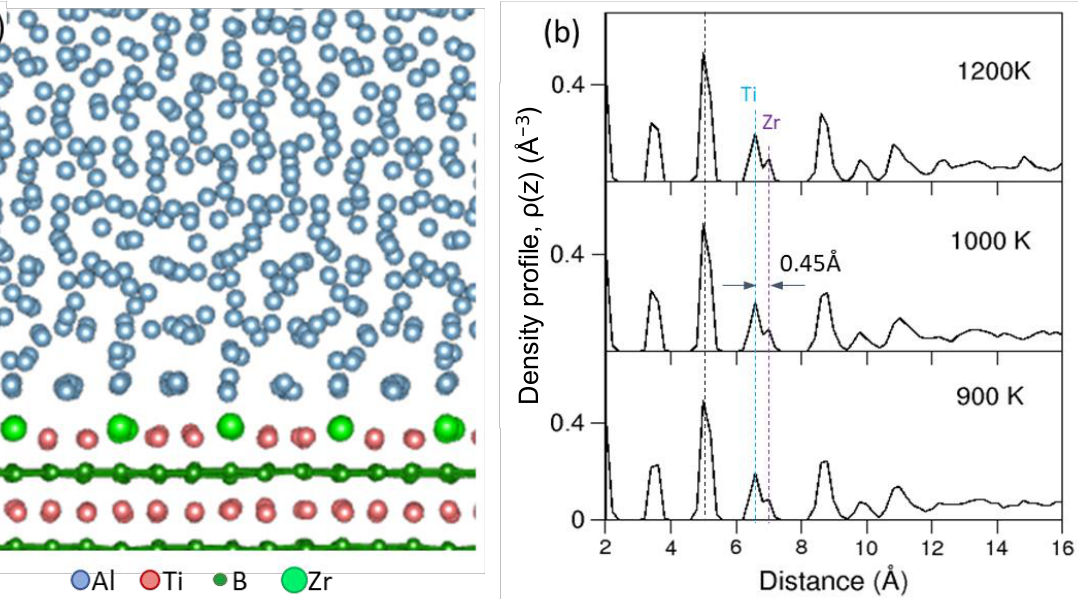
Figure 13. Ab initio MD simulation of Zr segregation at Al/TiB 2 interface [26]. ( a ) Snapshot of Al(liquid)/TiB 2 (Ti 2 Zr 2DC) interface along [1 0 1̅ 0] TiB 2 (Ti 2 Zr 2DC) direction simulated at 1000 K and ( b ) atomic density profiles ρ(z) across the Al(liquid)/TiB 2 (Ti 2 Zr 2DC) interface simulated at 900